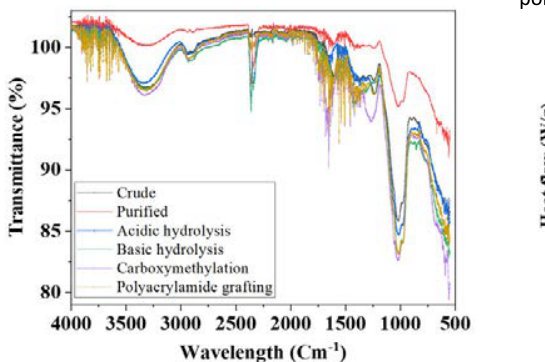
Fig. 2. Flow curves of A. modesta (Viscosity vs. shear rate)